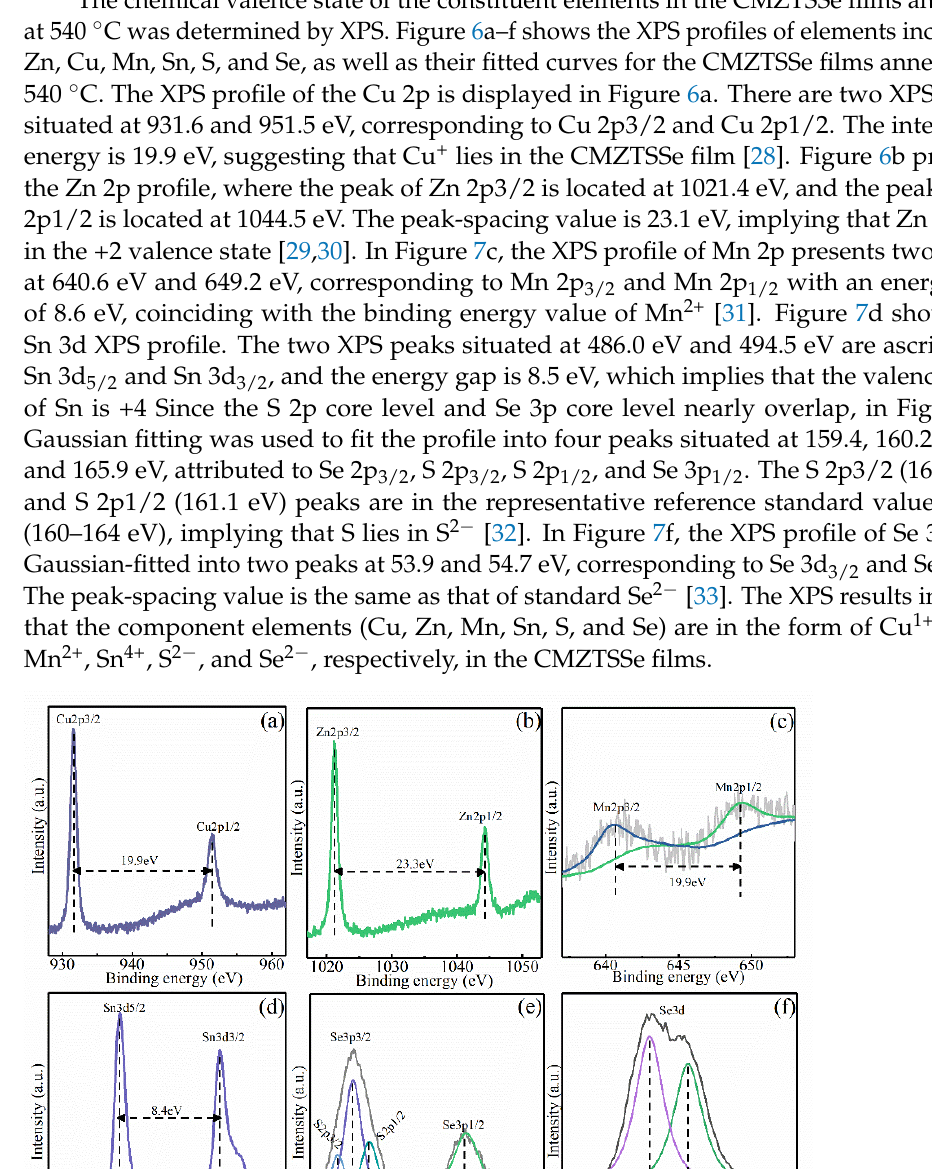
Figure 7. SEM surface images of the CMZTSSe films annealed at 500 °C ( a ), 520 °C ( b ), 540 °C ( c ), and 560 °C ( d ); EDS mapping images for Cu, Zn, Mn, Sn, S, and Se elements in the CMZTSSe film annealed at 540 °C ( e – j ). Table 1 lists the atomic percentages of the constituent elements in the CMZTSSe films annealed at 500, 520, 540, and 560 °C. The EDS results show that with the increasing seleni- zation temperature, the atomic percentage of Se gradually increases, whereas that of S gradually decreases. This is mainly due to the greater number of Se atoms replacing the S atoms with the increasing selenization temperature. When the selenization temperature was raised to 520 °C and 540 °C, the ratio of Mn/(Zn+Mn) was slightly lower. The reduc- tion in this ratio occurs to a lesser extent for the CMZTSSe film annealed at 540 °C; hence, it retains the compositional and microstructural quality of the thin film. As the seleniza- tion temperature increases to 560 °C, the elemental loss is significant. Zn and Mn are lost in excess, which affects the composition and microstructure of the films. This loss is due to the evaporation of Mn and Zn in the form of sulfide/selenide [14,34], e.g., Mn(Se,S), Mn(Se,S) 2 , Zn(Se,S), and Zn(Se,S) 2 , with the increasing selenization temperature. Thus, 540 °C can be considered the optimal selenization temperature.